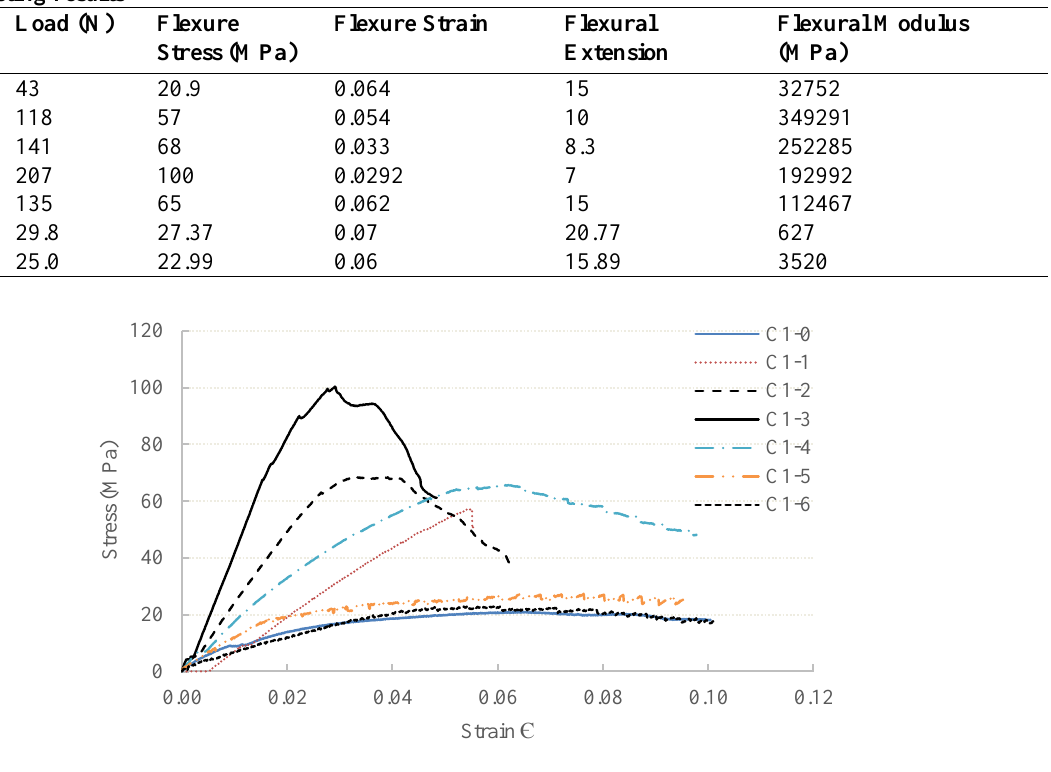
Fig. 13. Stress-Strain curves for flexures experimental tests of (C1-0, C1-1, C1-2, C1-3, C1-4, C1-5, and